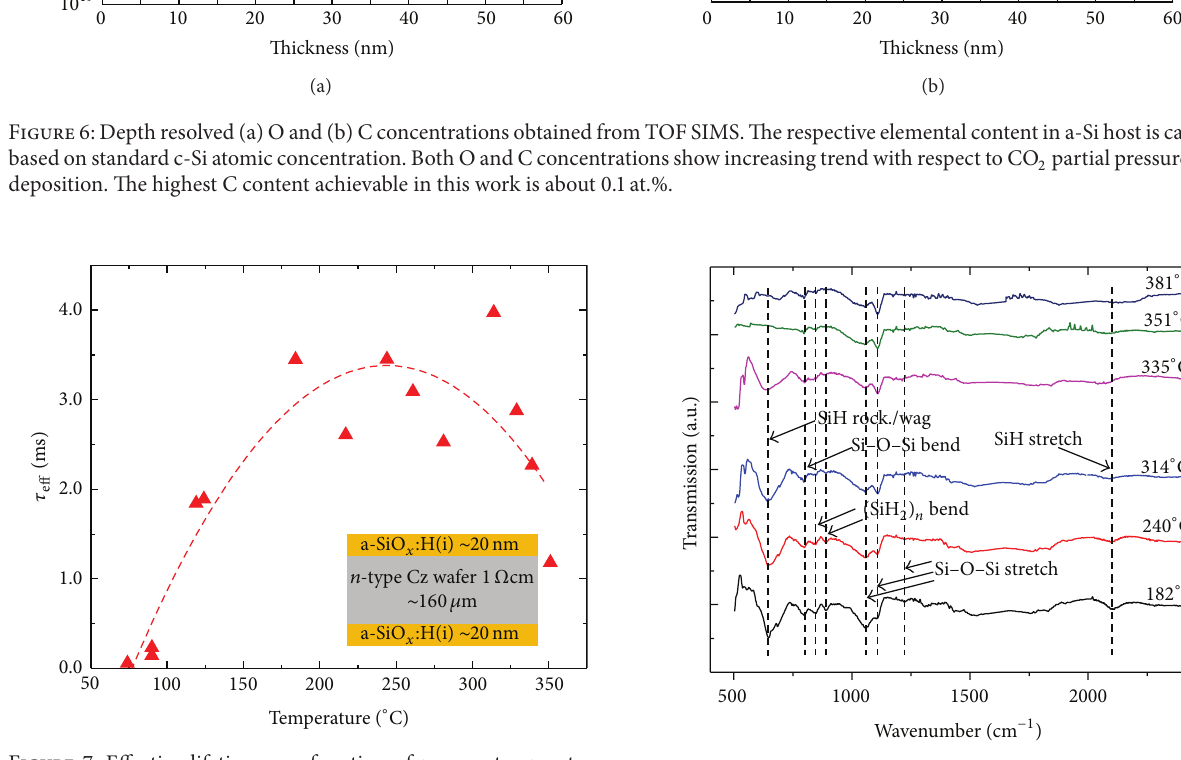
Figure 8: FTIR transmission spectra of a-SiO 𝑥 :H(i) films with different process temperatures. O in the film tends to be bonded in higher order configuration with increasing temperature. The diminishing peak at 640cm −1 and 2000 cm −1 indicates the effusion of H atoms. The disappearance of doublet at 845 cm −1 and 890 cm −1 indicates the optimised temperature. The lines are guide to the